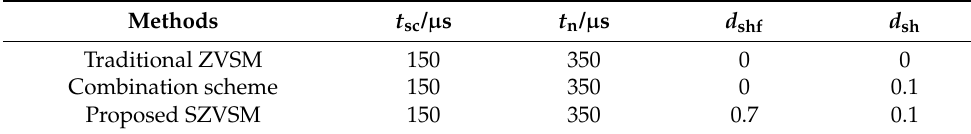
Table 2. Parameter settings of the three